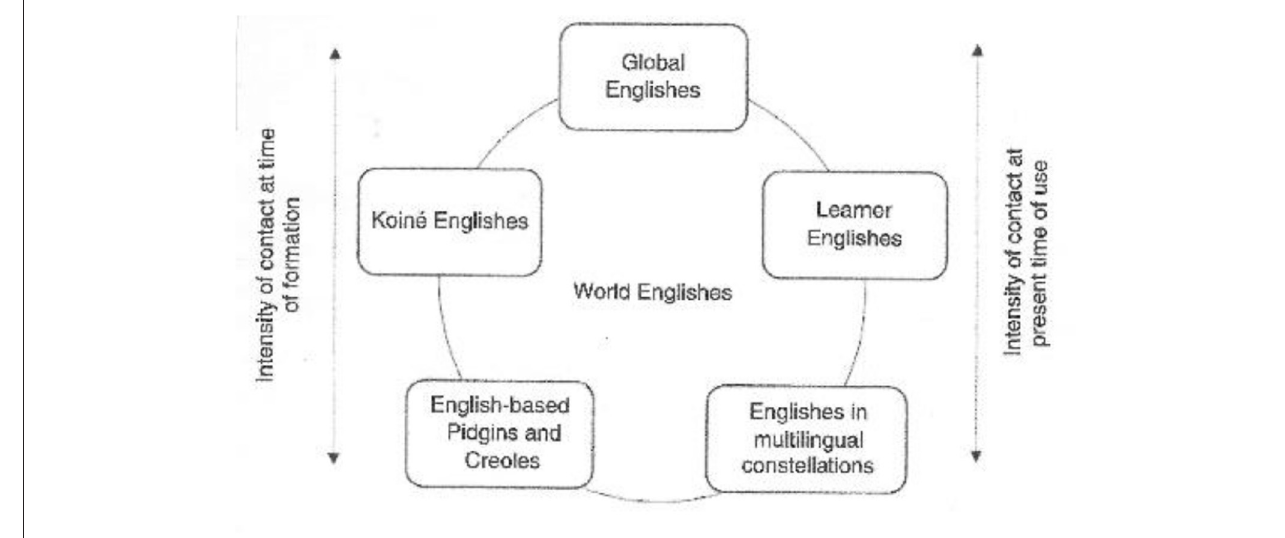
FIGURE 7 | Onysko’s “Language Contact Typology of world Englishes” (from Onysko, 2016, p.